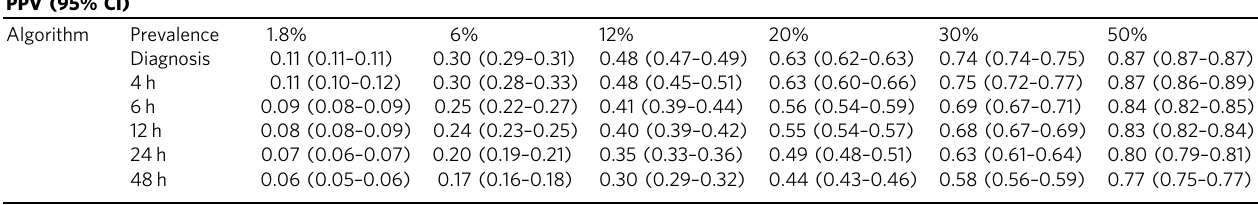
Table 4 Simulated PPV at different sepsis prevalence levels. PPV (95% CI) Algorithm